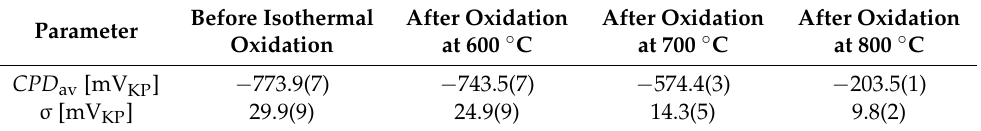
Table 6. Statistical parameters for the contact potential difference maps of the Ti-6Al-7Nb alloy surface before and after isothermal oxidation at 600, 700, and 800 ◦ C, where CPD av —the average value of CPD , σ —the standard deviation of the CPD av , and V KP —the voltage measured versus the Kelvin